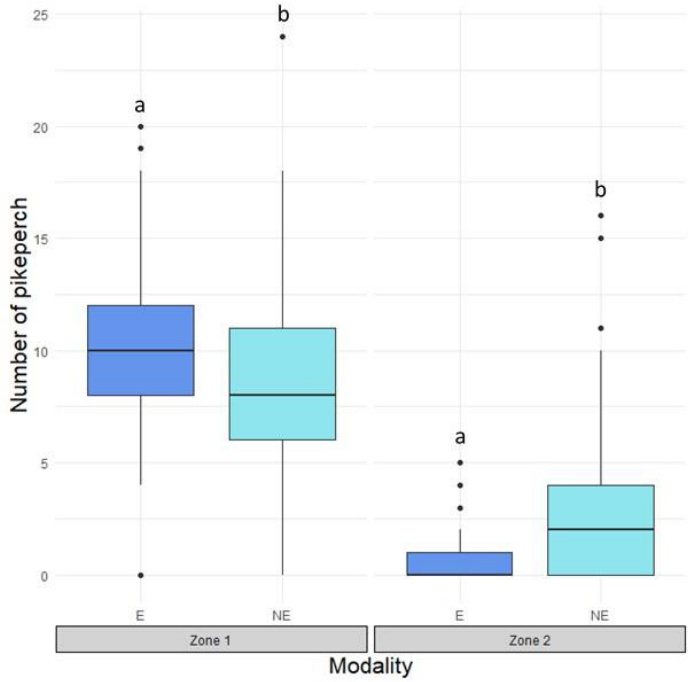
Figure 3. Median (quartiles) of pikeperch numbers in the different zones (1 and 2). Two different letters mean a significant difference ( p < 0.05). E: enrichment, NE: no enrichment. Sterlet were more distributed in zone 1 in the modality without enrichment (ANOVA, F 1, 4 = 92.2, p < 0.05). Sterlet were more distributed in zone 2 in the modality without enrichment (K-W test, X 2 = 8.5, p < 0.05) (Figure 4).